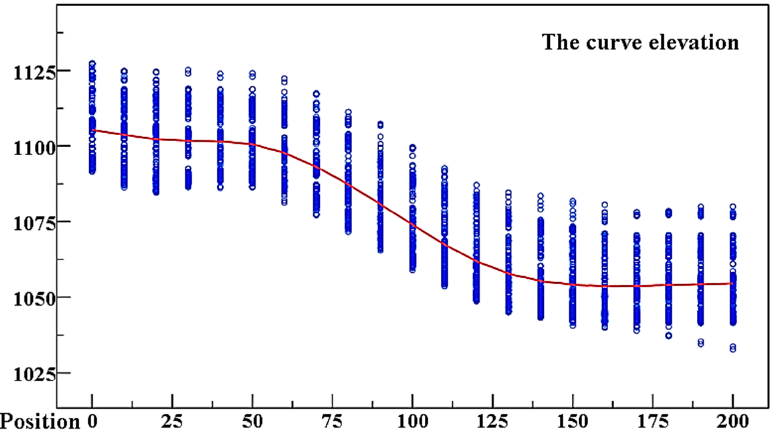
Figure 14. Fitting the cast blasting stockpile profile of the 40 m step height.